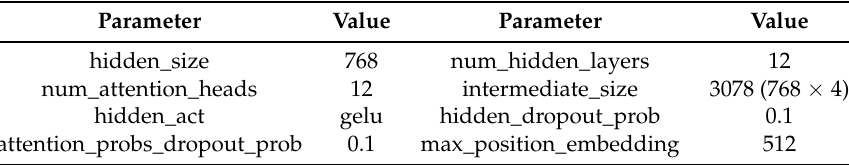
Table 1. Parameters chosen to configure the encoder architecture of Figure